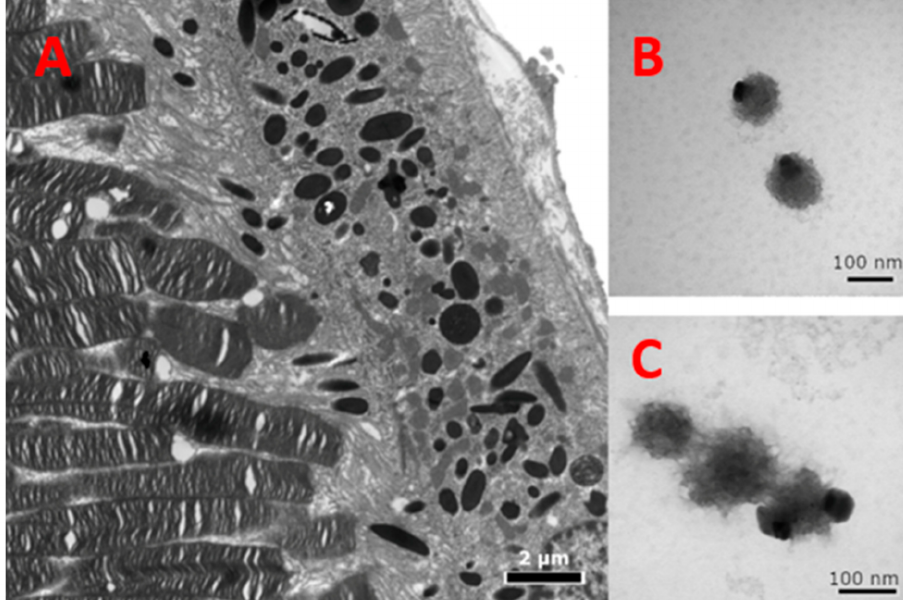
Figure 4. TEM of melanin-related products. ( A ) Within the RPE cells, the melanosomes are normally visualized with a dense black core of melanin, which protects the cells behind from the light. The left of the RPE are the photoreceptors, and to the right is the choroid. Direct magnification of 8000 × . ( B ) Isolated spherical-shaped melanin-related beads obtained from Tyr reaction using Tyr- MB. Direct magnification of 200,000 × . ( C ) A short chain of melanin-like beads assumably formed by polymerized melanin-related beads. Direct magnification of 250,000 × . Less dense regions are possibly a result of inefficient polymerization due to the absence of enzymes and scaffolding present in a